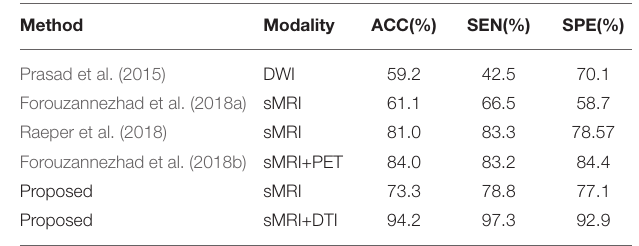
TABLE 3 | Classification performance comparison with pervious researches for distinguishing EMCI from